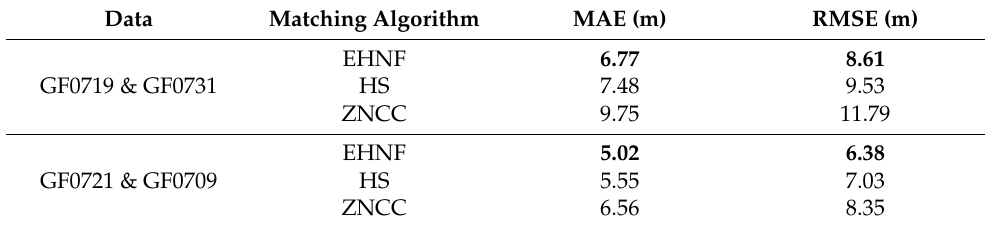
Table 3. Assessment of the elevation accuracy of mountainous DSMs.